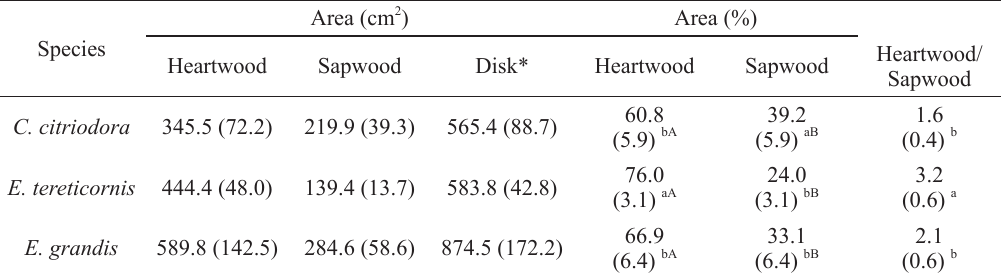
In the same column, average followed by at least one lowercase same letter do not differ by Tukey test (p <0.05). In the same line values followed by at least one uppercase letter do not differ by Student’s t test (p <0.05). *Disk means the entire disk